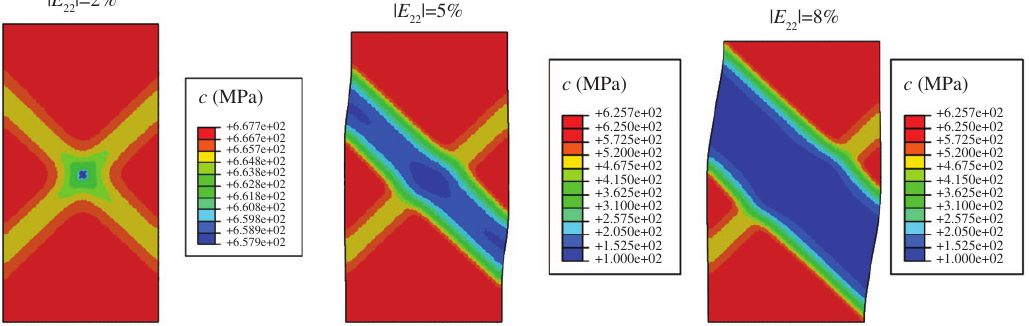
Figure 5 Sample S , general model behavior: spatial distribution of cohesion c at three applied compression strains | E 1